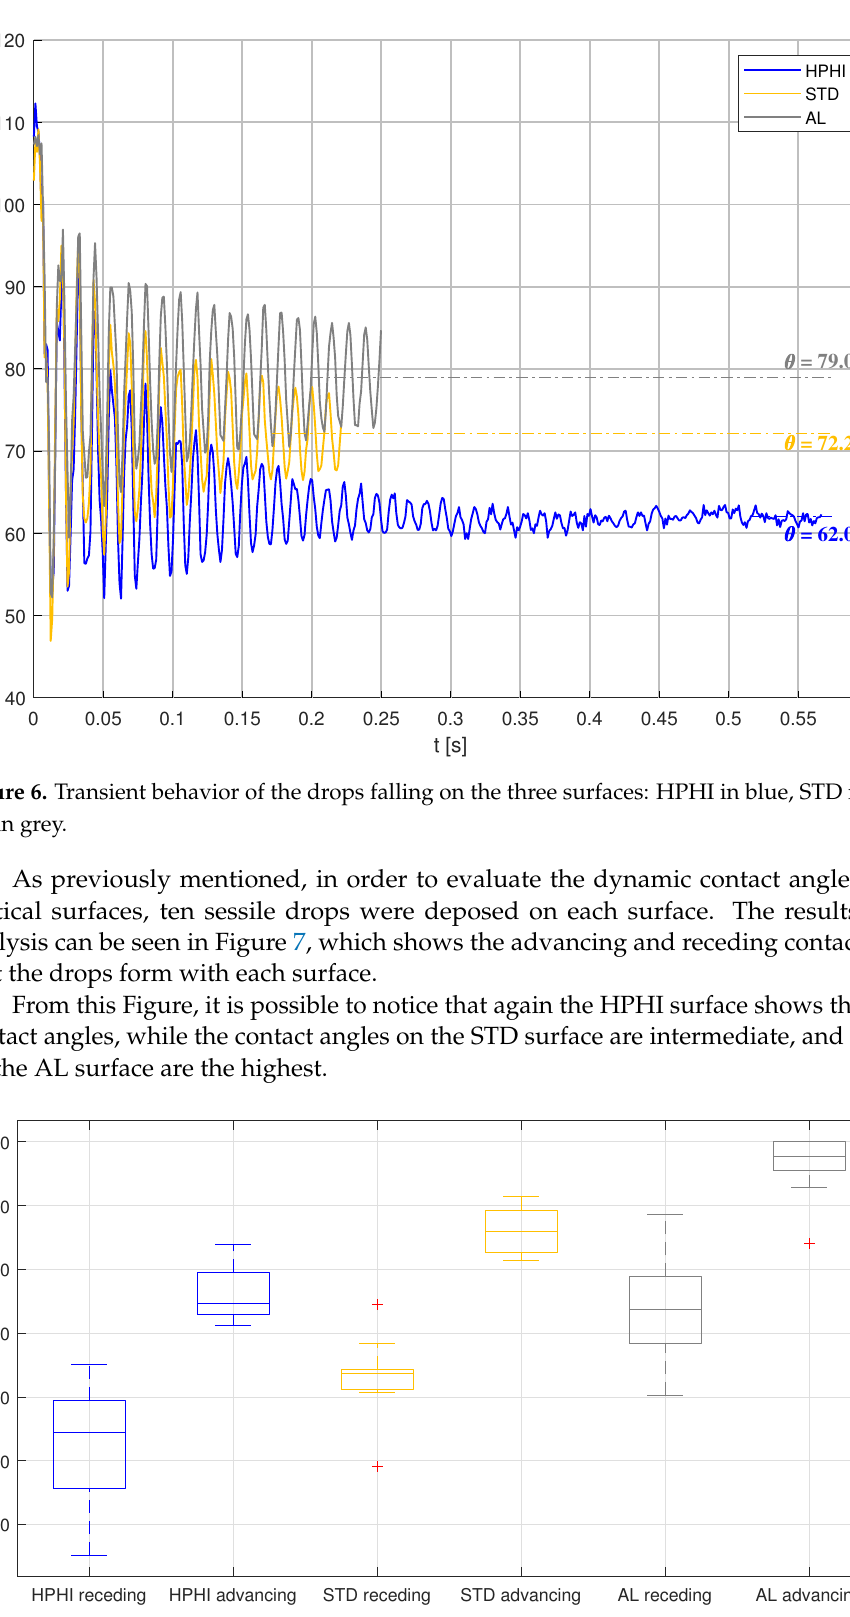
Figure 7. Boxplot representing the dynamic (advancing and receding) contact angles obtained by deposing sessile drops on each of the three surfaces in vertical orientation: HPHI in blue, STD in yellow, AL in